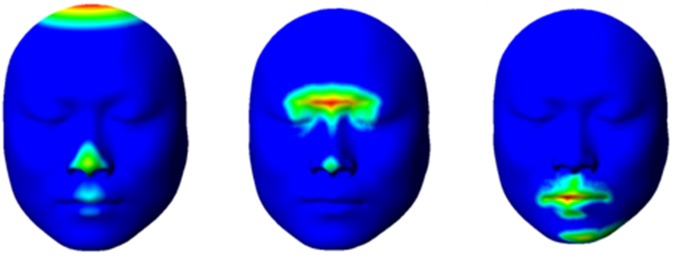
Reflected region by SPCA sparse principal component.